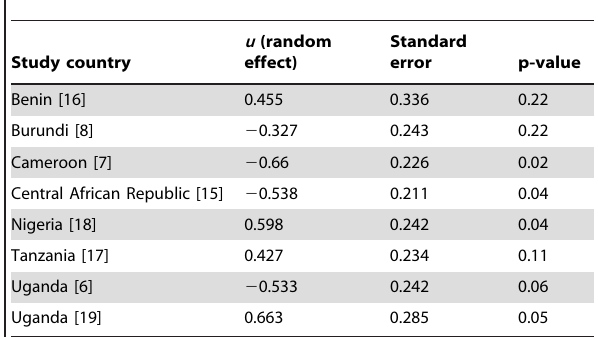
Table 4. Empirical Bayes estimates of the random effects due to inter-study heterogeneity from the regression models of epilepsy prevalence vs. onchocerciasis